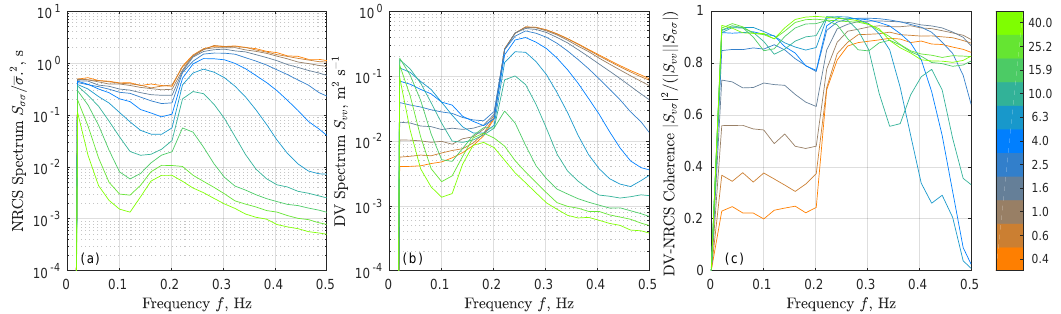
Figure 10. Simulated spectra of ( a ) NRCS and ( b ) DV, and ( c ) DV-NRCS coherence for various footprint size at U = 6 m/s and M = 10.